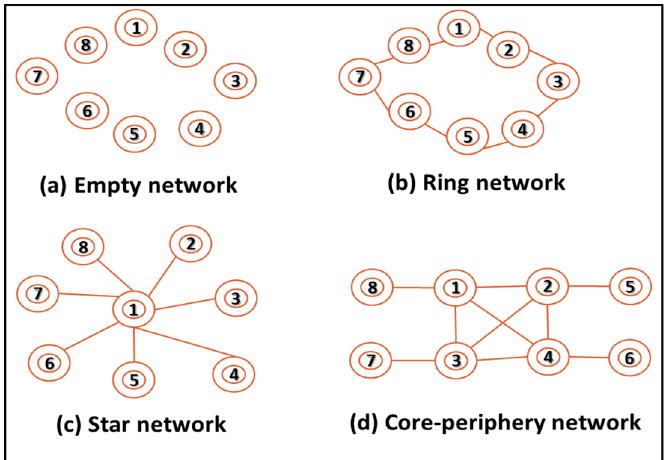
Figure 38. Equilibrium pattern-based four network structures used in production technologies (Ref. [138]).